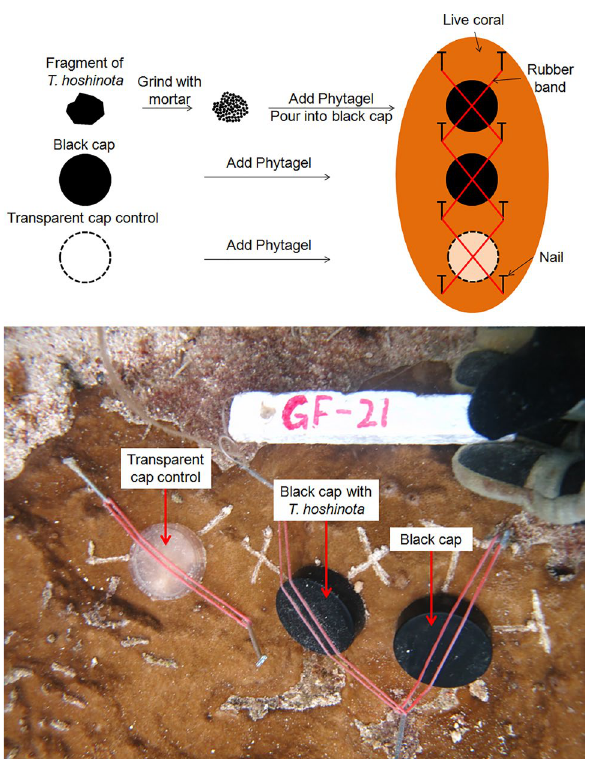
Figure 9. The design of sponge mixture